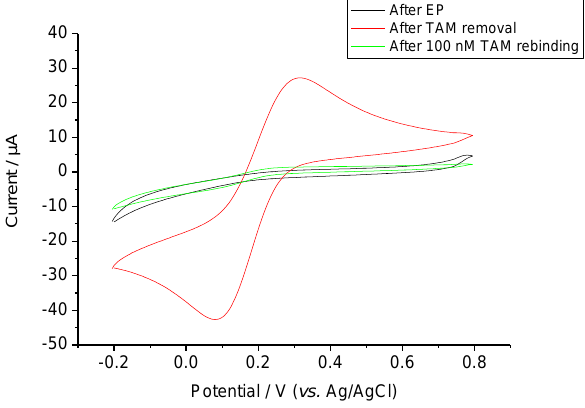
Figure 3. Overlay of CVs of MIP electrode after electropolymerisation (black), after TAM removal (red), and after TAM rebinding (green) in 10 mM ferricyanide at a scan rate of 50